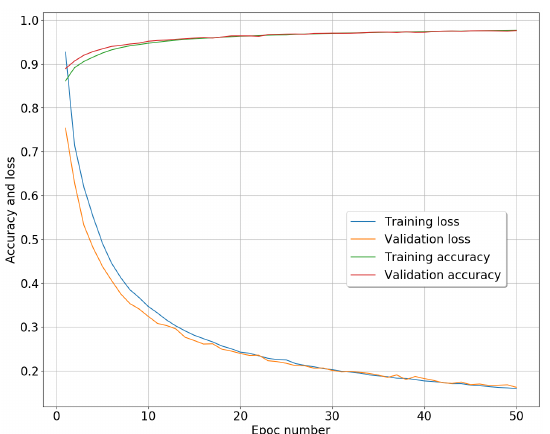
Figure 5. Loss function and accuracy for the training and validation sets, respectively, obtained during the training phase of the TanDEM-X U-Net-like CNN for forest